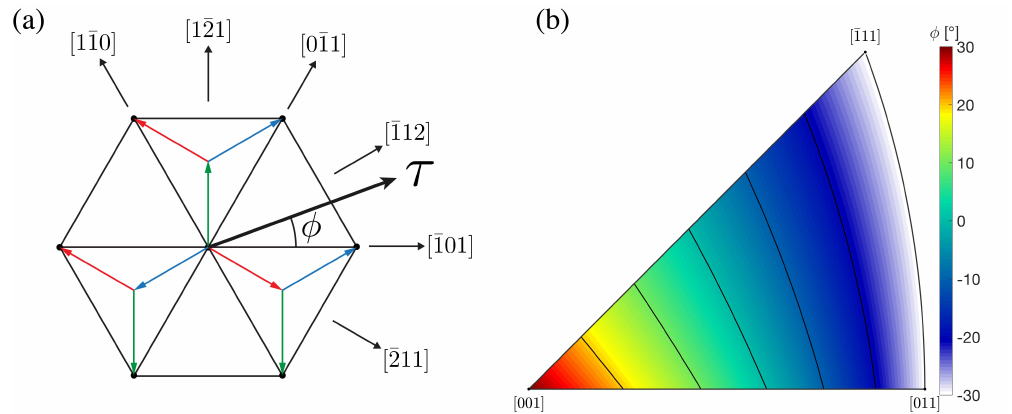
Figure 4. ( a ) Schematic diagram of the atomic configuration on the (111) plane, where the atoms would sit on the corners of the triangles. The coloured arrows show the routes an atom in the middle point can take to get to the six neighbouring positions, generating an intrinsic stacking fault after being swiped by the leading partial. φ is in this context the angle between the shear stress on this plane and the (cid:104) 110 (cid:105) direction closest to that orientation. ( b ) Inverse pole figures showing the value of the angle φ of the slip plane with the highest shear stress under uniaxial tensile loading.